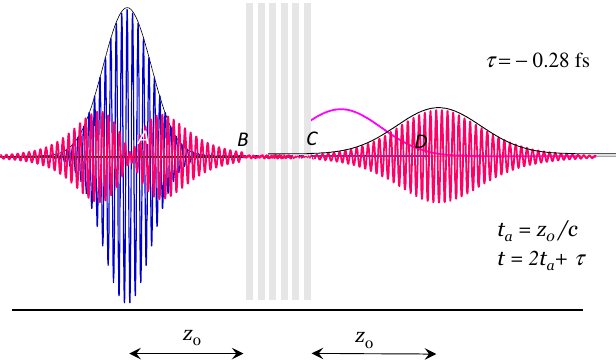
Figure 11. The Gaussian WP prepared, at t = 0, at a distance z 0 = L = 10 l c from the SL, as explained in Figure 9b (see the blue curve), moves towards D , passing through the SL ( LR ) 7 , and reaches this point (see the red curves), as predicted, at t = τ D = 2 z 0 / v g + τ (cid:39) 54.02 fs. The WP is partially transmitted and partially reflected. Not all frequencies are transmitted because the transmission coefficients at the center of the packet are larger than in the tails. Thus, a dip is formed in the reflected (red)